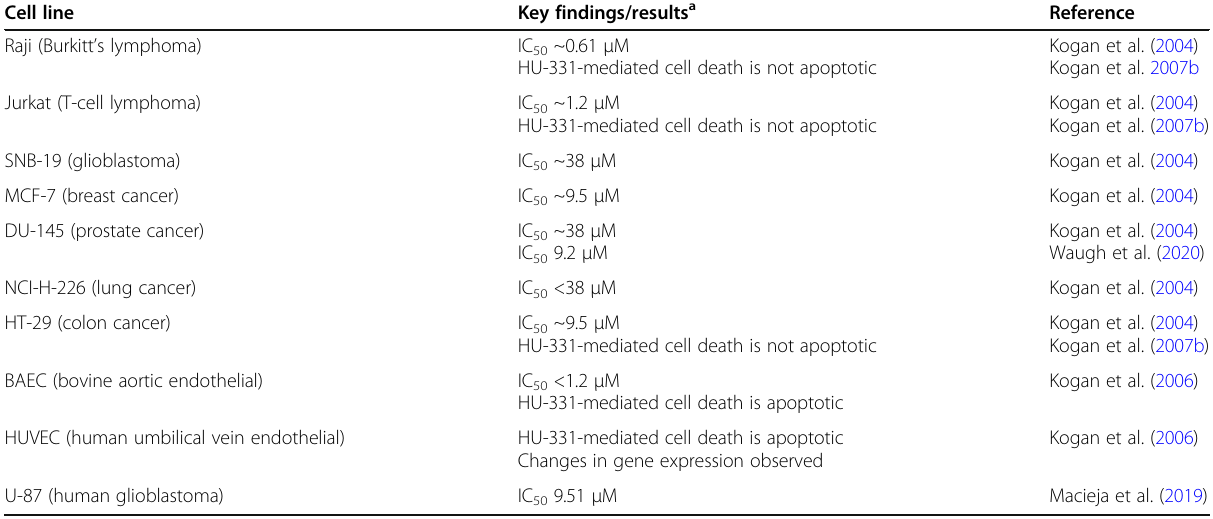
Table 1 Results from cell-based assays with HU-331 Cell line Key findings/results